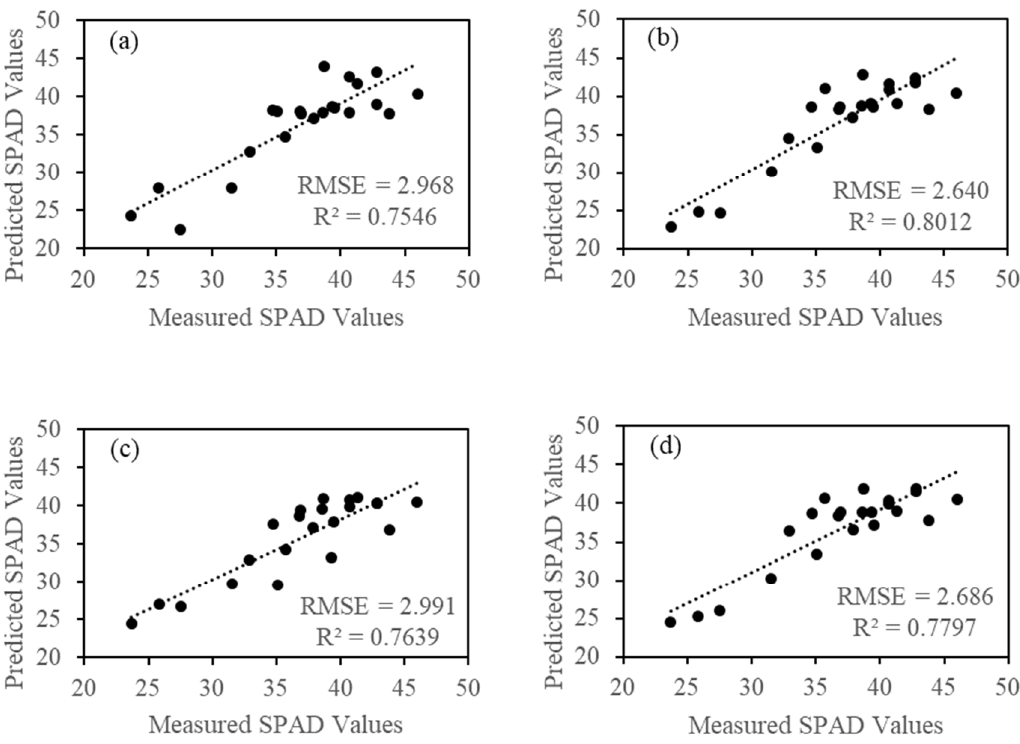
Figure 16. Scatterplots between the measured SPAD value and the predicted SPAD value using the validation set. Note: ( a ) GPR-M; ( b ) RFR-M; ( c ) SVR-M; ( d ) GBRT-M.